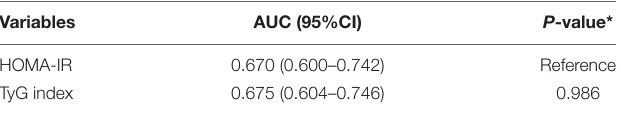
Asterisk compared with HOMA-IR. Abbreviations: TyG, Triglyceride-glucose; HOMA-IR, homeostasis model assessment-insulin resistance; CHF, congestive heart